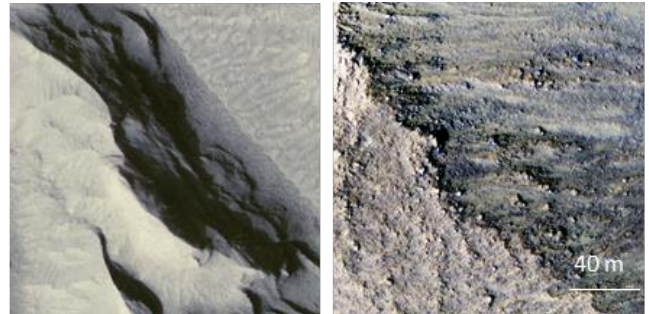
Figure 4. Examples of HiRISE satellite imagery.